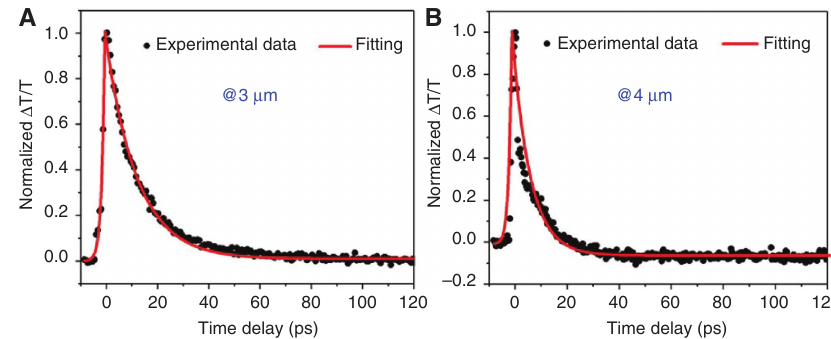
Figure 3: Pump–probe measurement results of the InSe film. Transient transmittance versus time delays at (A) 3 μ m and (B) 4 μ m.